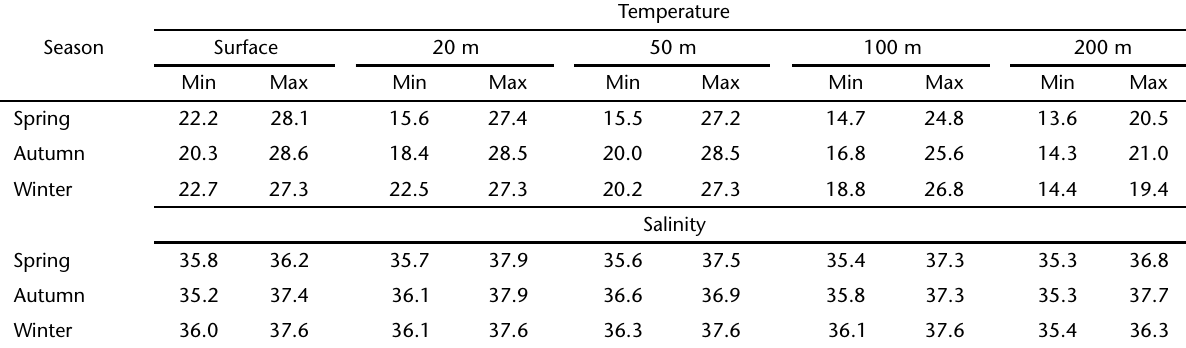
Table I. Minimum (Min) and maximum (Max) values of temperature (°C) and salinity obtained at surface, 20 m, 50 m, 100 m and 200 m depth during spring/1998, autumn/2000 and